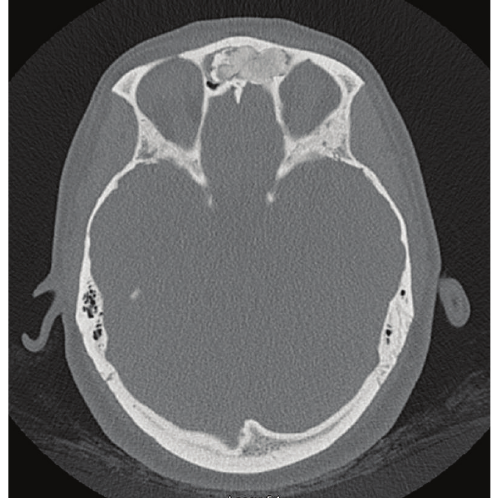
Figure 3: Coronal T1 weighted MRI showing the osseous mass filling the left frontal sinus and extending into the right.